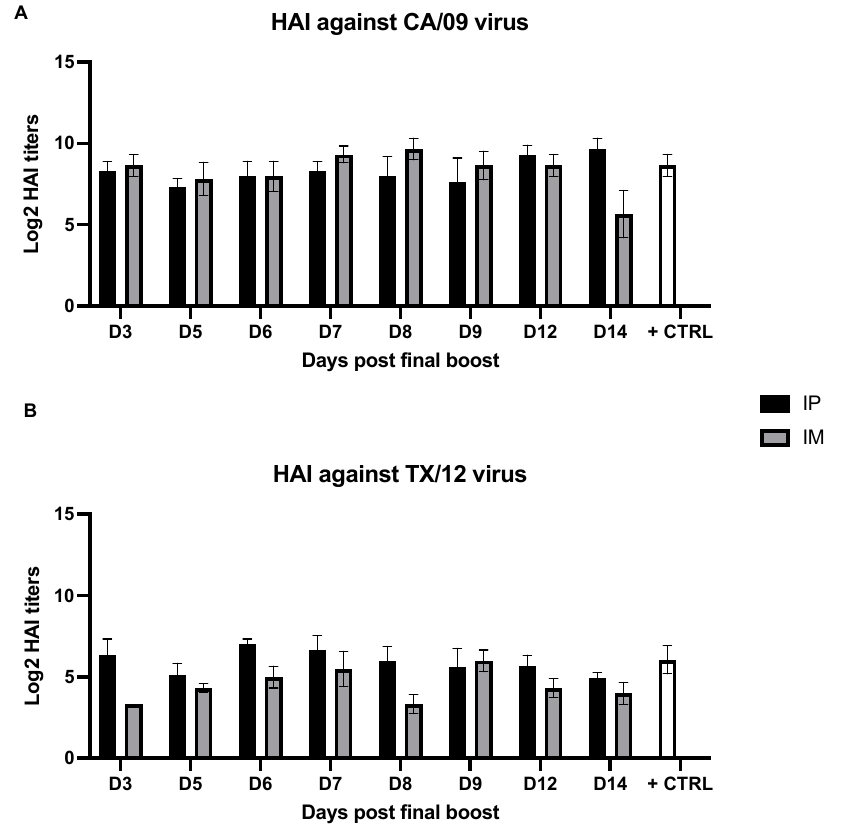
Figure 3. HAI from sera collected at different time points following the final boost of mice that were IP- or IM-immunized with the combination of COBRA Y2 and NG2 rHAs. The H1N1 A/Califor- nia/07/2009 (CA/09) ( A ) and the H3N2 A/Texas/50/2012 (TX/12) ( B ) were used as representative vi- rus strains to detect the HAI activity following the immunization with the COBRA Y2 and NG2 rHAs. Shown results are expressed as absolute mean values plus SEM (error bars) using the differ- ent mouse group sera. The limit of detection of the assay corresponds to a serum dilution of 1:10. Absence of statistically significant differences ( p > 0.05) among the HAI titers of the sera collected at different time points against the CA/09 and TX/12 strains within the analyzed day 3–14-time frame was determined as specified in the Materials and Methods section.